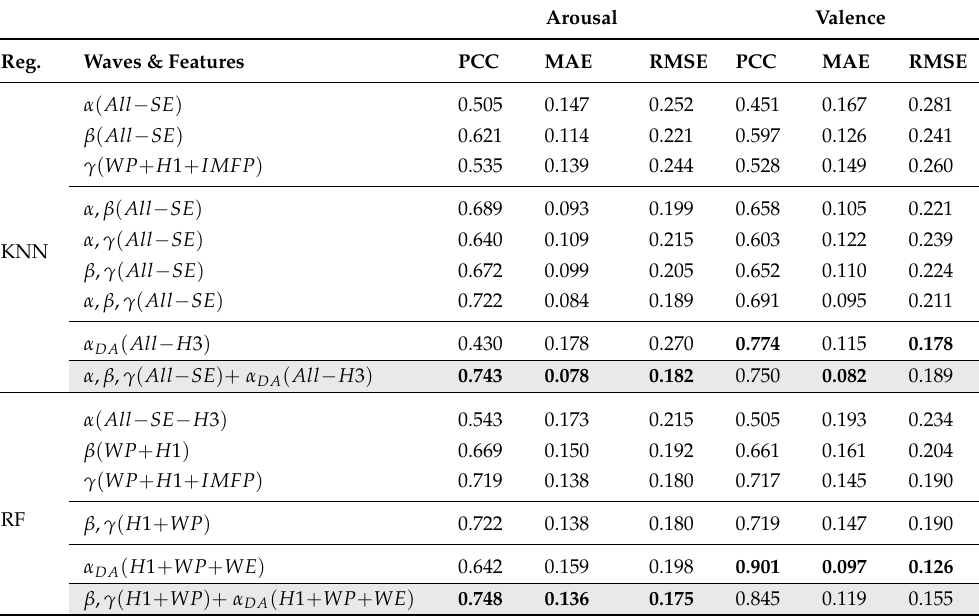
Table 5. Results for the different features by waves, and their combinations. Values in bold represent the best results for KNN and RF, for valence and arousal. Grey rows represent the selected features.